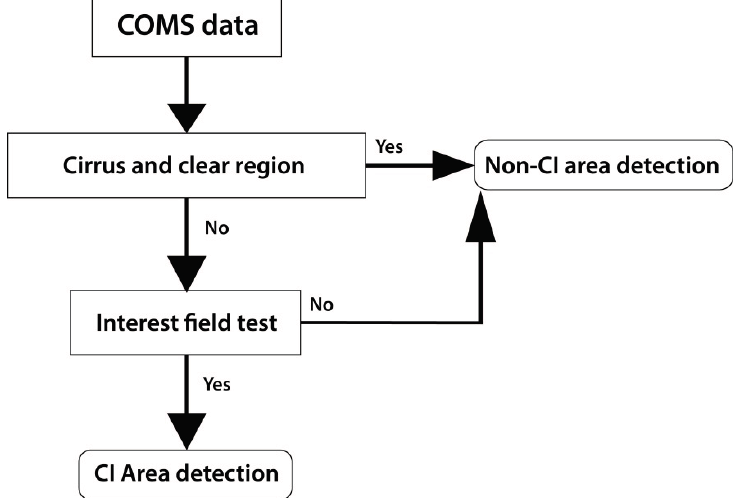
Figure 1. Processing flow of the binary classification of COMS MI images for CI detection based on machine learning